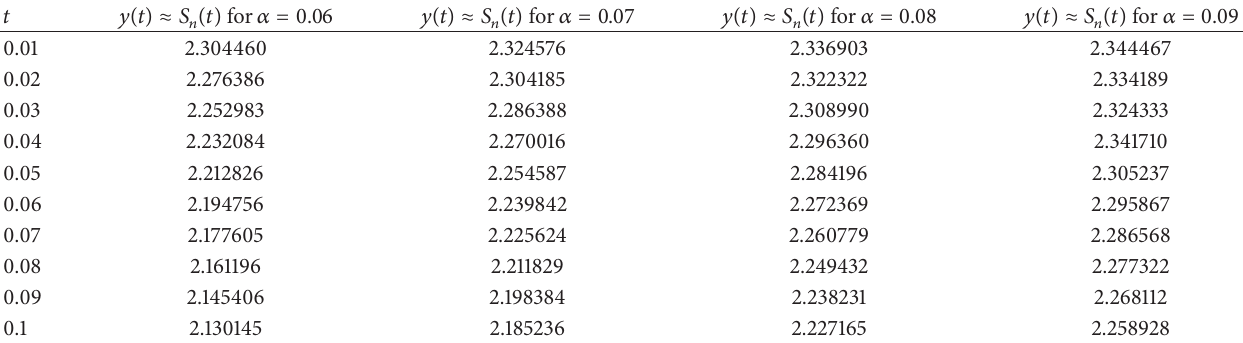
Table 8: Approximate solutions obtained by GTSM in Example 3 for different order of derivatives. 𝑡